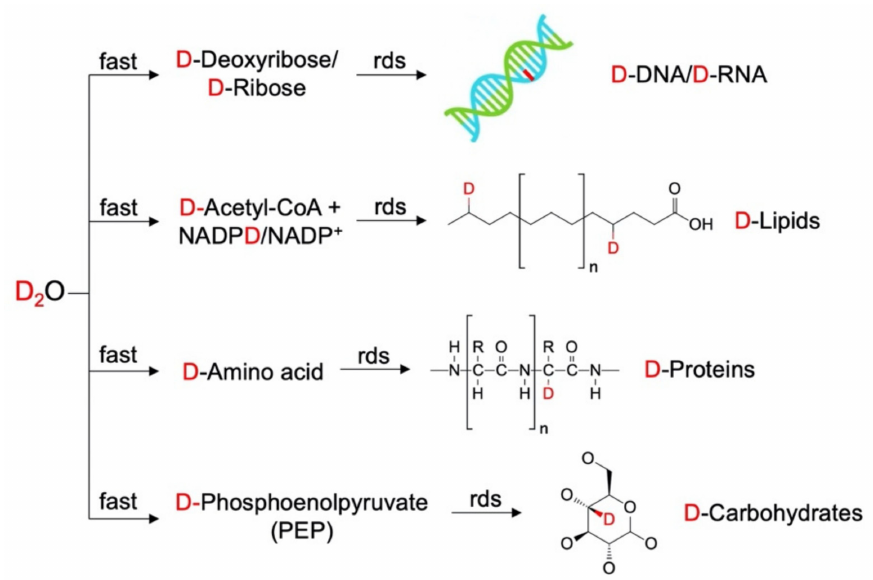
Figure 8. D 2 O as a unique and universal tracer for different biomolecules. ‘rds’ stands for rate- determining